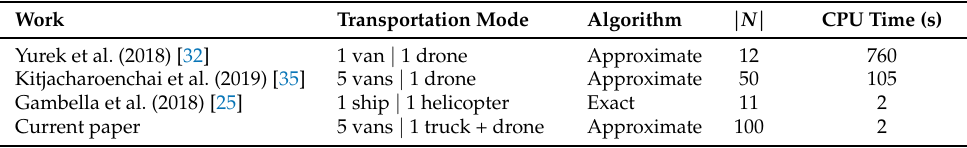
Table 5. Result comparison with the closest related studies in the